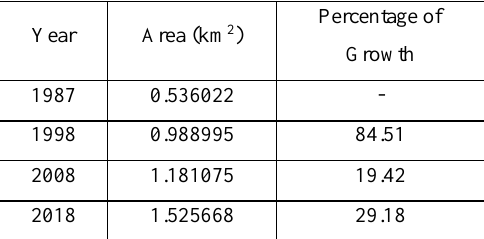
Table 2. Change in the total built-up areas in Wad al Abbas between 1987 and 2018